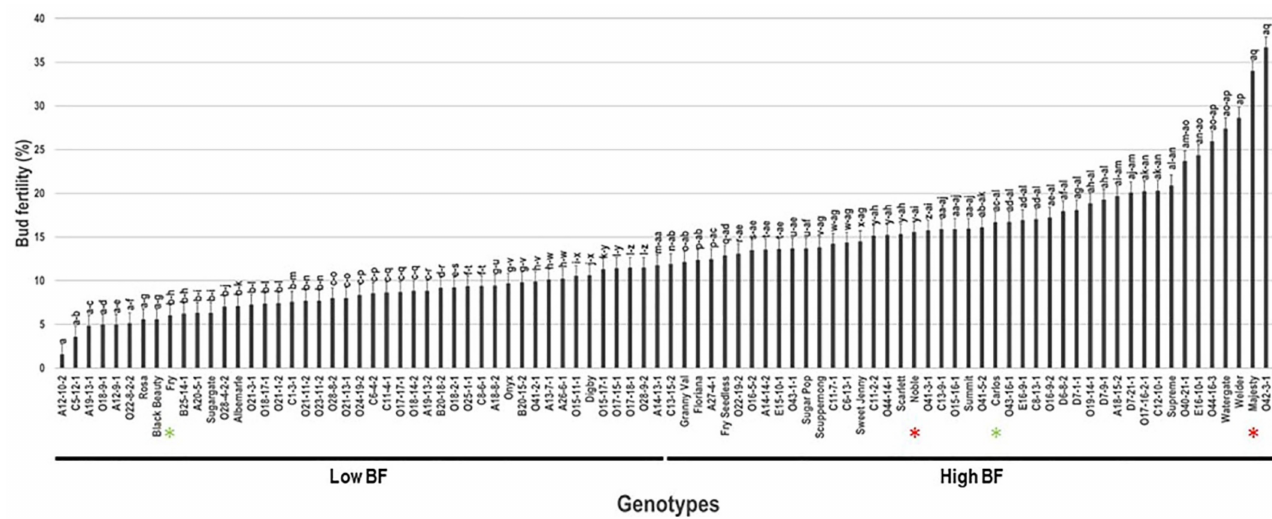
Figure 2. Characterization of bud fertility (BF) trait among muscadine population ( n = 90). The bars represent the mean BF ( ± SD) results from three biological replicates (thee vines) over three years ( n = 9). The y-axis refers to bud fertility (%). Means within columns for the same letter followed by different letters differ significantly by Tukey’s test ( p < 0.05). Based on median BF (~11.8%), the population was divided into two groups that showed low and high BF. Other details are as in Figure 1.